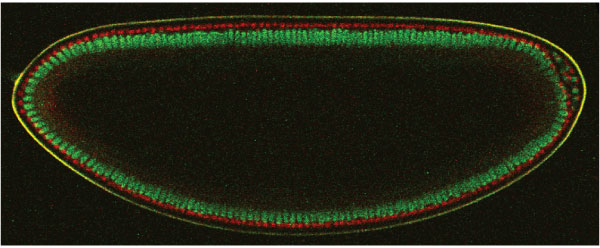
Basal movement of nuclei during stage 5 in living Histone2A-GFP embryos. Two optical slices through the middle of a living embryo are superimposed. The red image was taken at the beginning of stage 5, whereas the green image was taken at the end. The bright line is the water-oil interface at the vitelline membrane, and was used to align the two images. All nuclei move inwards and elongate during stage 5. Anterior is to the left and dorsal is up.